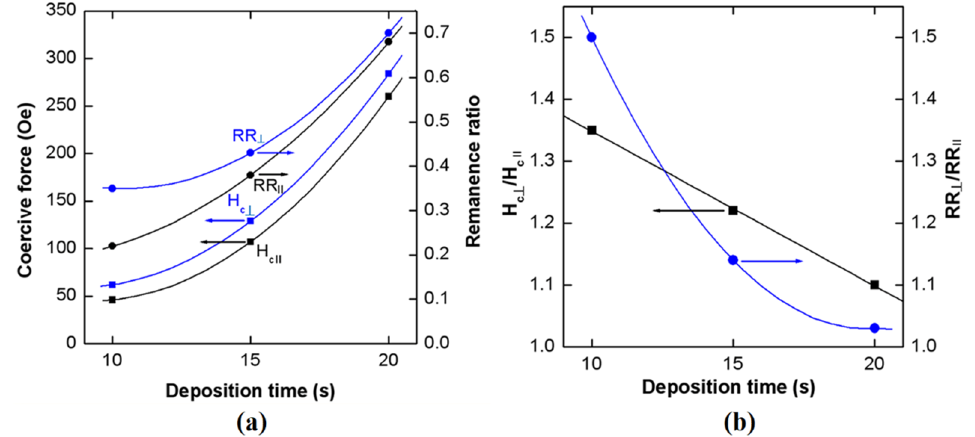
Figure 8. ( a ) Change in the coercive force (H c ) and the remanence ratio (RR) with increase in the Fe deposition time on GaAs nanowires produced on (111)B substrates. ( b ) Dependence of the anisotropy of coercive force (H c ⊥ /H cII ) and remanence ratio (RR ⊥ /RR II ) on the Fe deposition time. The lines are a guide for eyes.